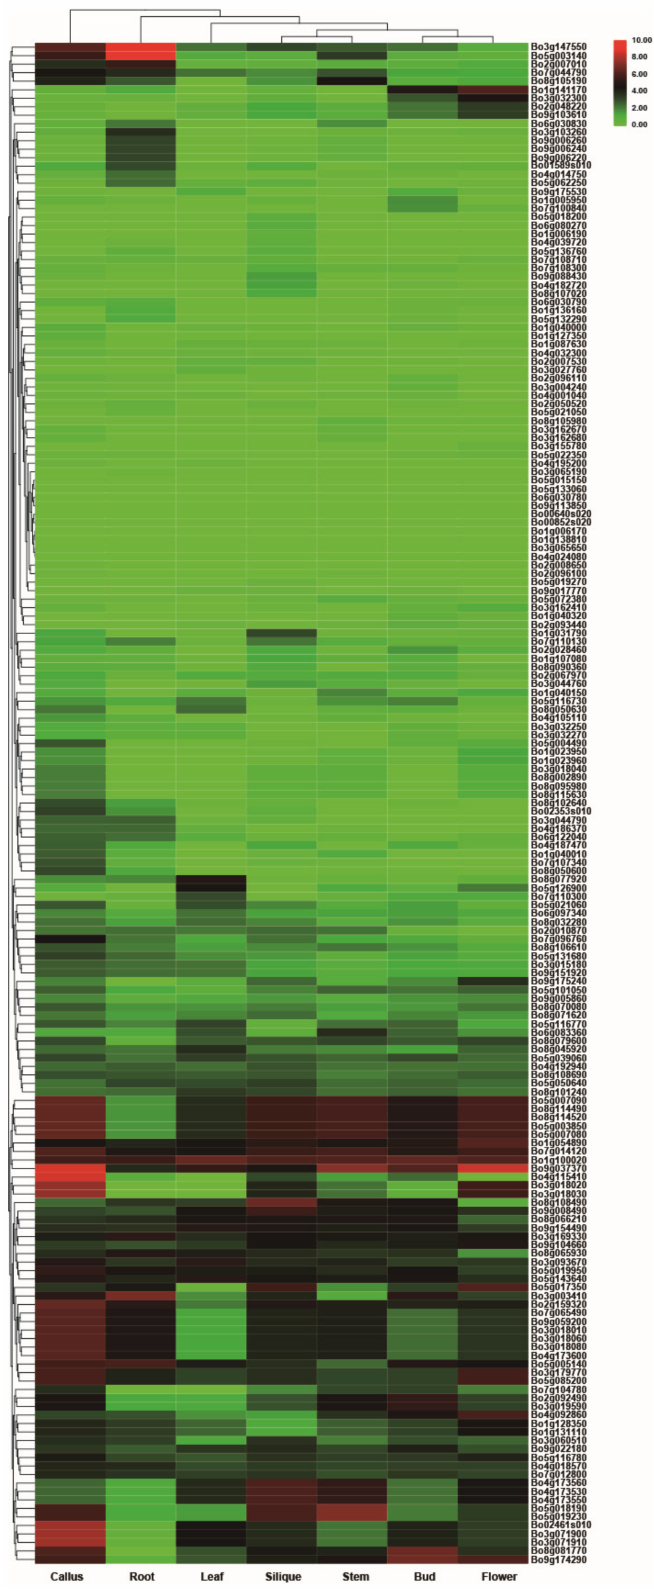
Figure 10. Tissue-specific expression of putative 2OGDs in B. oleracea . Representative expression of putative 2OGDs of B. oleracea in the callus, root, leaf, silique, stem, bud, and